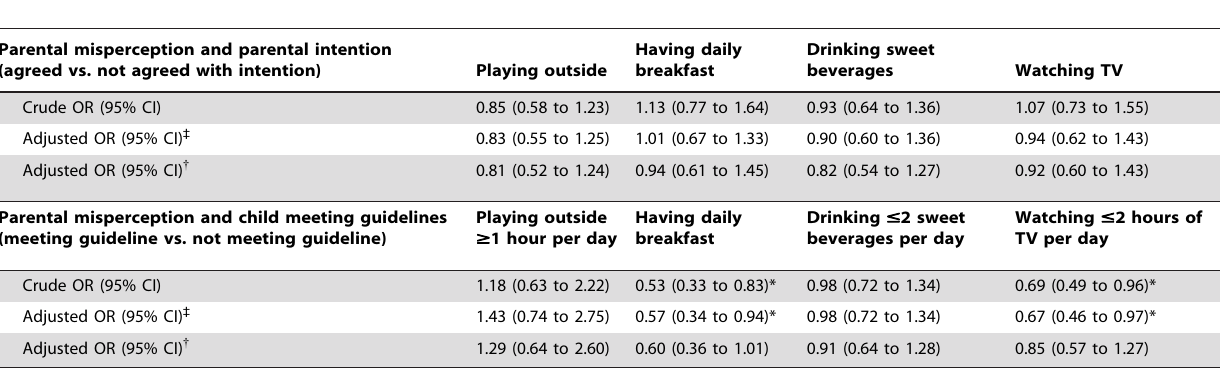
Table 3. Logistic regression analyses, presenting the association between parental misperception and 1) parental intention to improve child engagement in overweight-related health behaviors, and 2) child meeting guidelines regarding these behaviors.